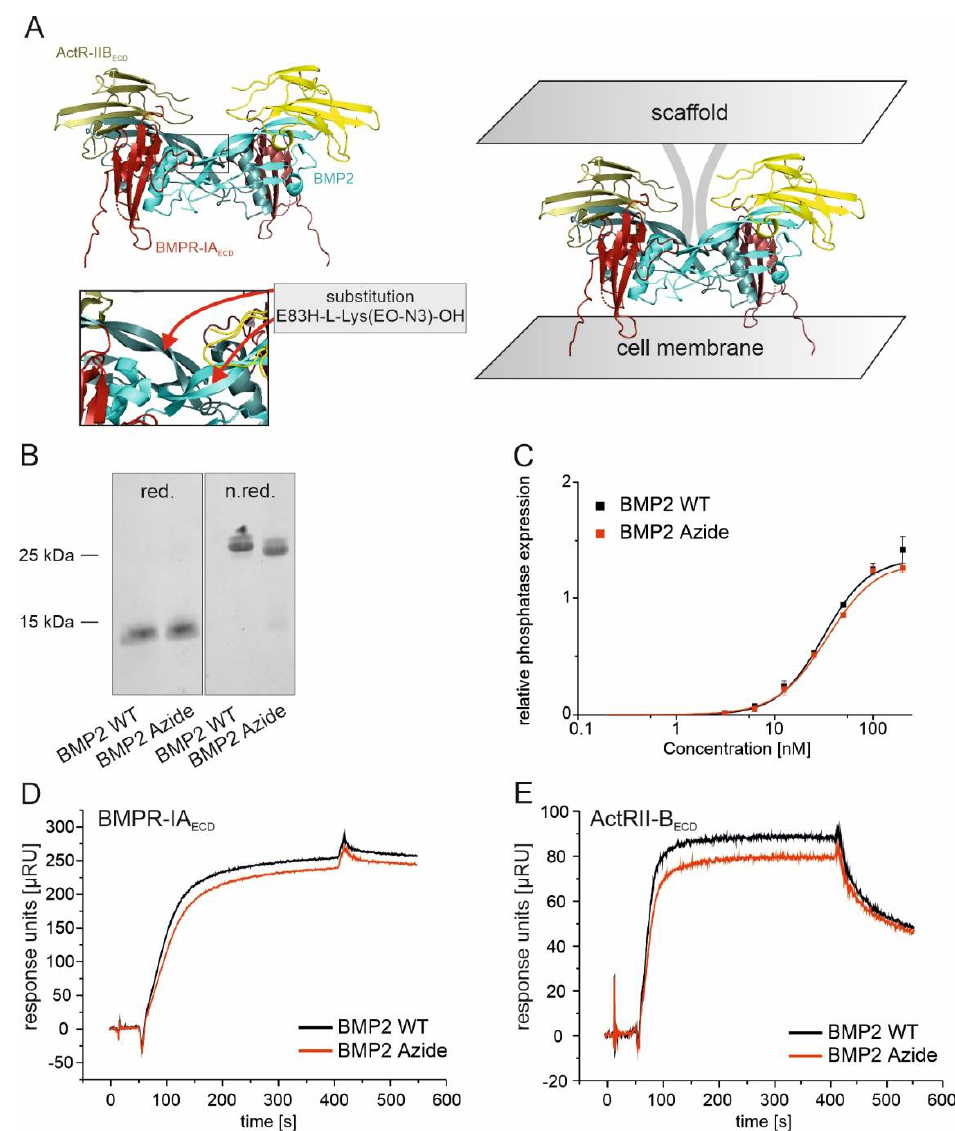
Figure 1. Structural and cell-based analyses of BMP2 Azide compared to the wild type BMP2. ( A ) Ribbon structure of the heterohexameric BMP2:BMPR-IA ECD :ActR-IIB ECD complex [33]. Cartoons of the structures were created using the pyMol 3.7 software. The underlying coordinates were provided by the public database RCDS PDB (accession number 2H64). The insert with higher magnification indicates the position of the introduced artificial amino acid (H-L-Lys(EO-N 3 )-OH) within BMP2 (monomers are depicted in light green, the receptor ectodomain of BMPR-IA ECD (red) and ActR-IIB ECD (yellow)). BMP2 Azide being coupled to the scaffold is oriented toward the cell membrane (right panel); ( B ) Coomassie Brilliant Blue staining of BMP2 WT and BMP2 Azide under reducing (left panel) and non-reducing (right panel) conditions; ( C ) The graph shows dose- dependent ALP expression in C2C12 cells induced by BMP2 Azide (red) and BMP2 WT (black). Relative phosphatase expression shows absorption at 405 nm after subtraction of the background absorption at 405 nm; ( D , E ) Surface plasmon resonance (SPR) sensorgrams depict the interactions of the indicated ligands with ( D ) BMPR-IA ECD and ( E ) ActR-IIB ECD at 80 nM ligand concentrations. Apparent K D values (presented in text) were calculated as described in the Materials and Methods section. Statistical analysis for the SPR data was performed using unpaired t-test. No significant difference between the ligands was